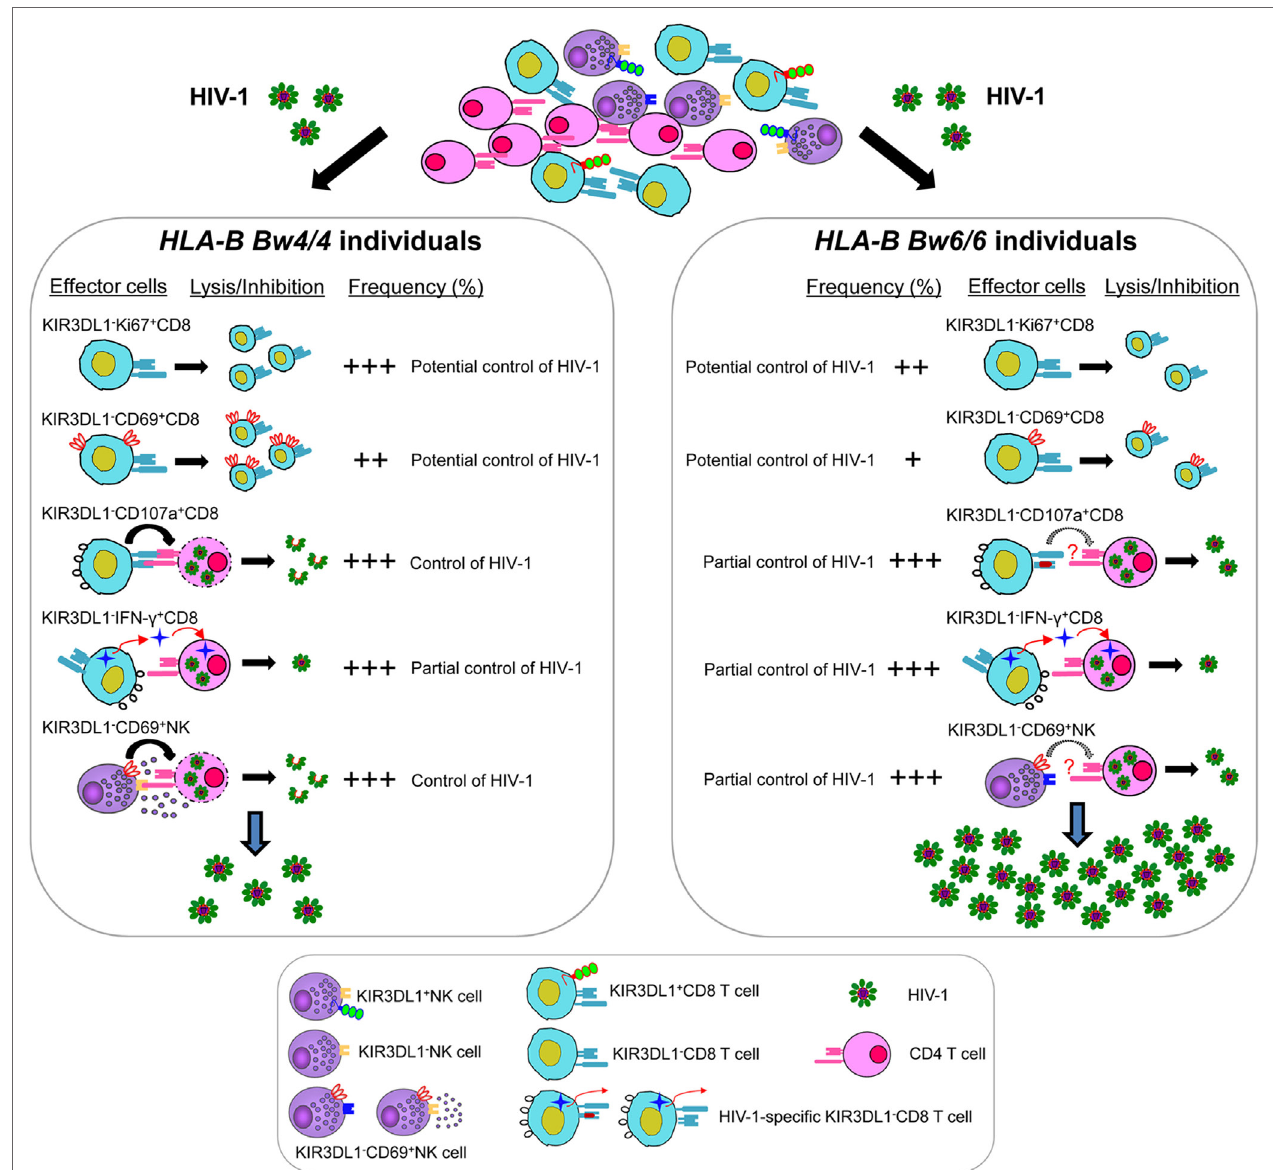
FigUre 8 | Model for KIR3DL1 − CD8 + T cell and KIR3DL1 − natural killer (NK) cell controlling human immunodeficiency virus type 1 (HIV-1) infection in individuals with distinct HLA-B serological genotypes. HIV-1-specific KIR3DL1 − CD107a + CD8 + T cells and KIR3DL1 − CD69 + NK cells were associated with inhibiting HIV-1 replication in Bw4 -homozygous individuals, but not efficient in Bw6 -homozygous individuals. The levels of HIV-1-specific KIR3DL1 − IFN- γ + CD8 + T cells were similar in both individuals homozygous for Bw4 and Bw6 , may be associated with partial control of HIV-1 infection. Moreover, the proliferative capacity of KIR3DL1 − Ki67 + CD8 + T and the early activation of KIR3DL1 − CD69 + CD8 + T cells, which can potential control of HIV-1 infection, were significantly higher in HIV-1-infected individuals homozygous for the Bw4 than in those homozygous for Bw6 . Nevertheless, the frequency and function of KIR3DL1-expressing CD8 + T/NK cells was much lower than that of KIR3DL1-negative CD8 + T/NK cells in HIV-1-infected individuals, regardless of Bw4 or Bw6 homozygosity. Thus, KIR3DL1-expressing CD8 + T/NK cells, which associated with the loss of multiple functions, may do not play a crucial role in controlling HIV-1 infection in the early stages of HIV-1